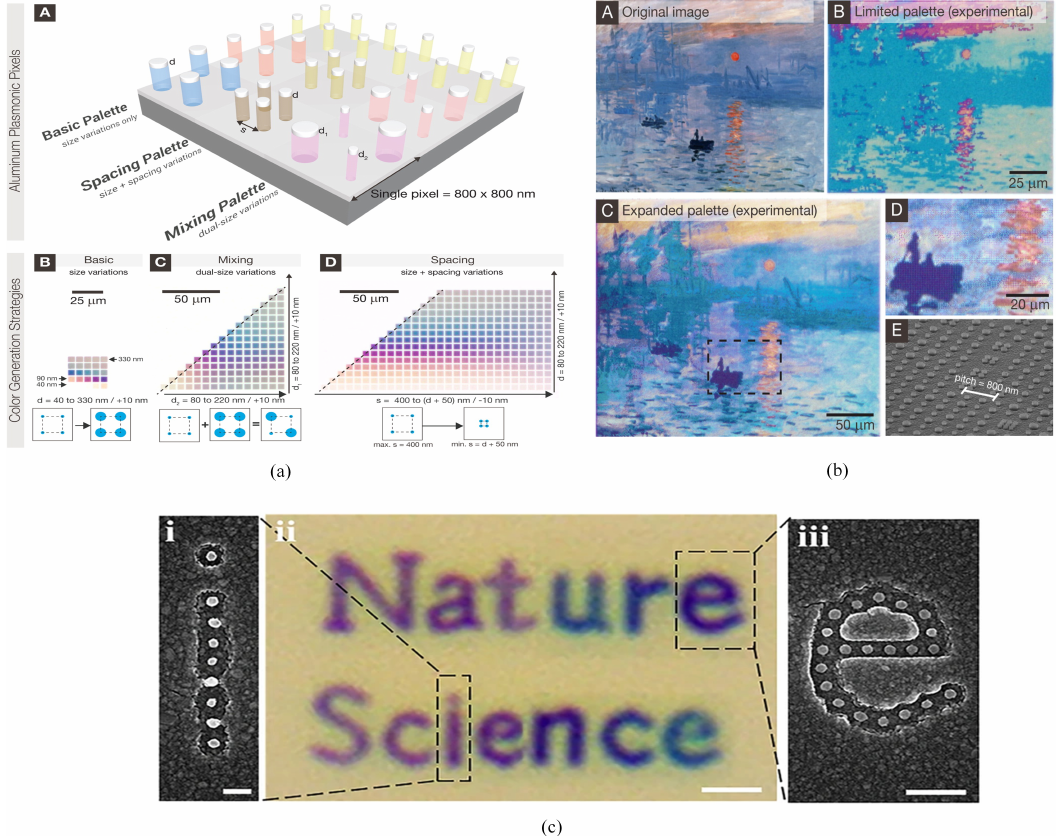
Figure 5. ( a ) schematic diagram of aluminium based nanohole-nanodisk hybrid structure. ( b ) The impact of variation in diameter, periodicity and (spacing) diameter and periodicity on the color image due to color toning and mixing is demonstrated experimentally. Reproduced with permission of [170]. Copyright American Chemical Society, 2014. ( c ) Color printing resolution test pattern for LSPP based nanostructures at the scale bar of (i) 200 nm, (ii) 1 µ m and (iii) 500 nm